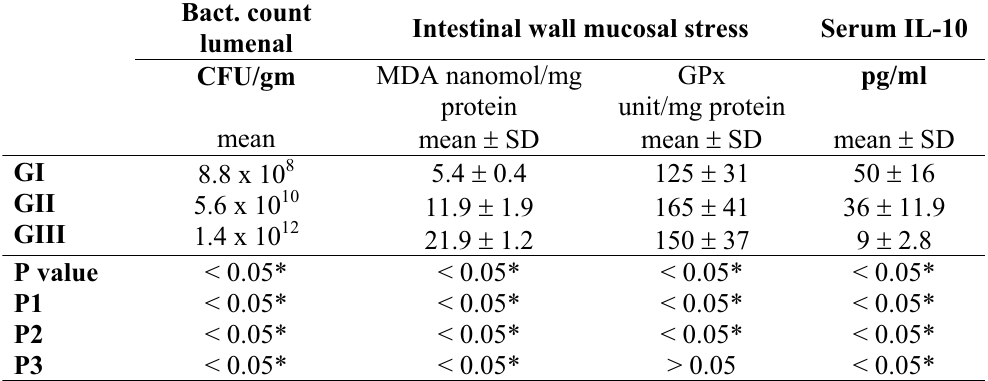
TABLE 1 - Bacterial translocation predisposing factors among the studied groups Bact. count